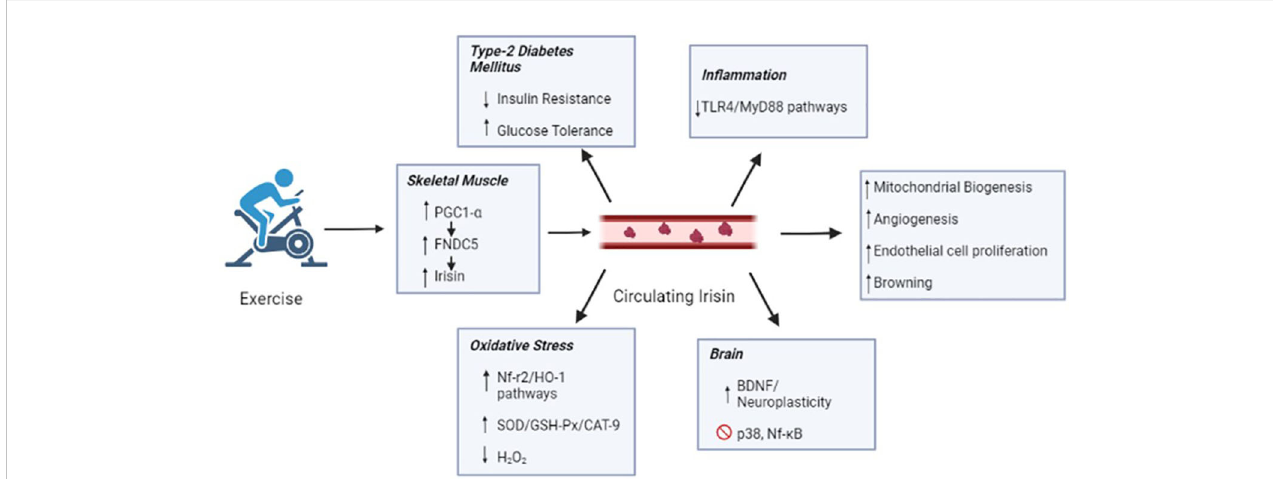
FIGURE 2 Irisin secreted by skeletal muscle during the exercise reaches blood circulation and in general ameliorates the mitochondrial biogenesis, angiogenesis, endothelial cell proliferation and browning. Such bene fi ts might explain the protective effects of exercise against type-2 Diabetes Mellitus, in fl ammation, oxidative stress and neurodegenerative disease. PGC1- a , peroxisome proliferator-activated receptor gamma coactivator 1 alpha; FNDC5', fi bronectin type III domain-containing protein 5; TLR4, toll-like receptor 4; MyD88, myeloid differentiation primary response 88; HO-1, heme oxygenase-1; SOD, dismutase superoxide; GSH-Px, peroxidase glutathione; CAT-9, catalase; H202, oxygen peroxide; BDNF, brain-derived neurotrophic factor and NF-kB, factor nuclear kappa